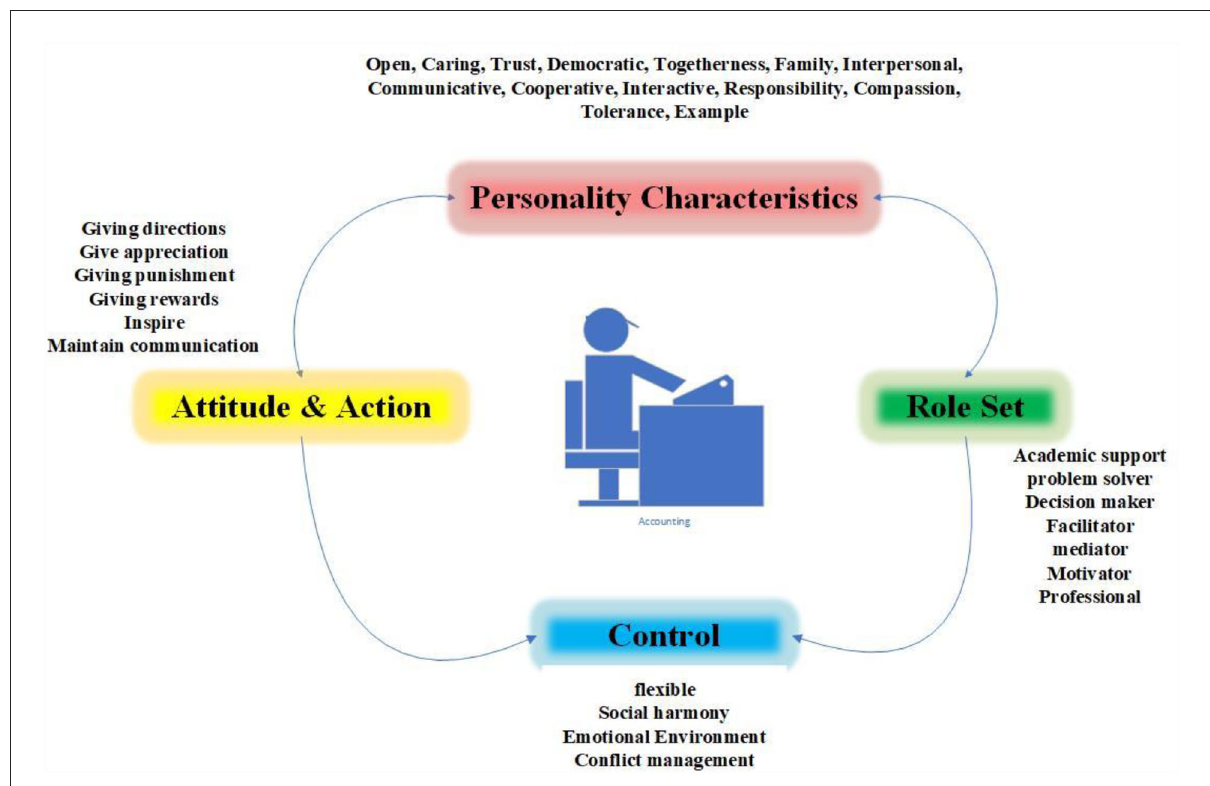
FIGURE7 Conceptual framework of the principal’s role in school culture. Source: Visualization of research findings compiled by the